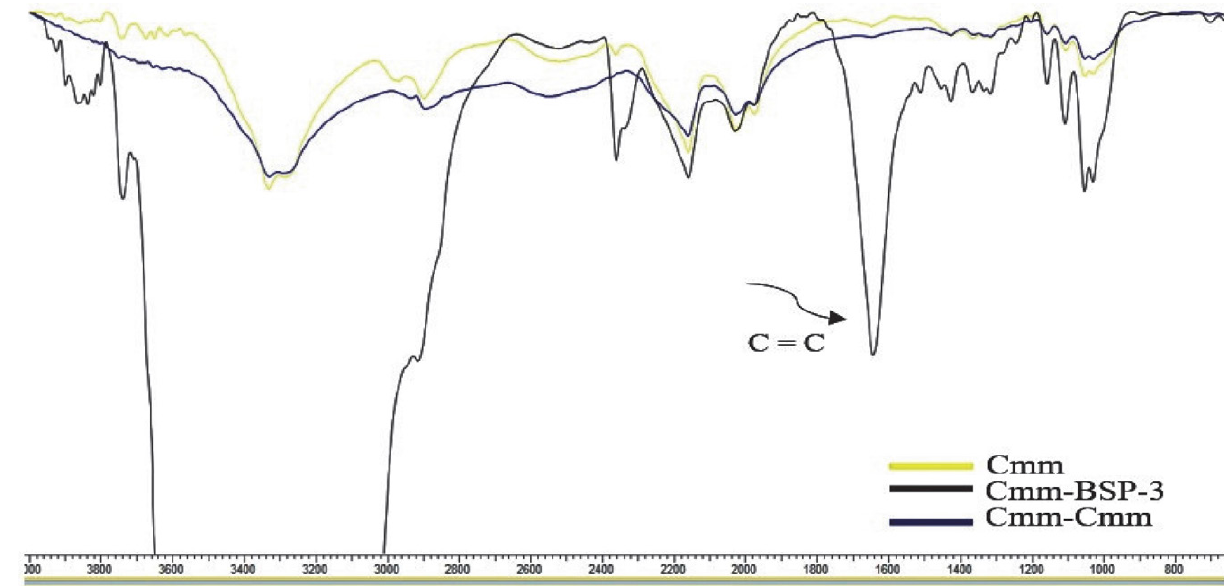
Figure 5. Band recorded by BSP-3 disappears with Cmm-Cmm hybrid.